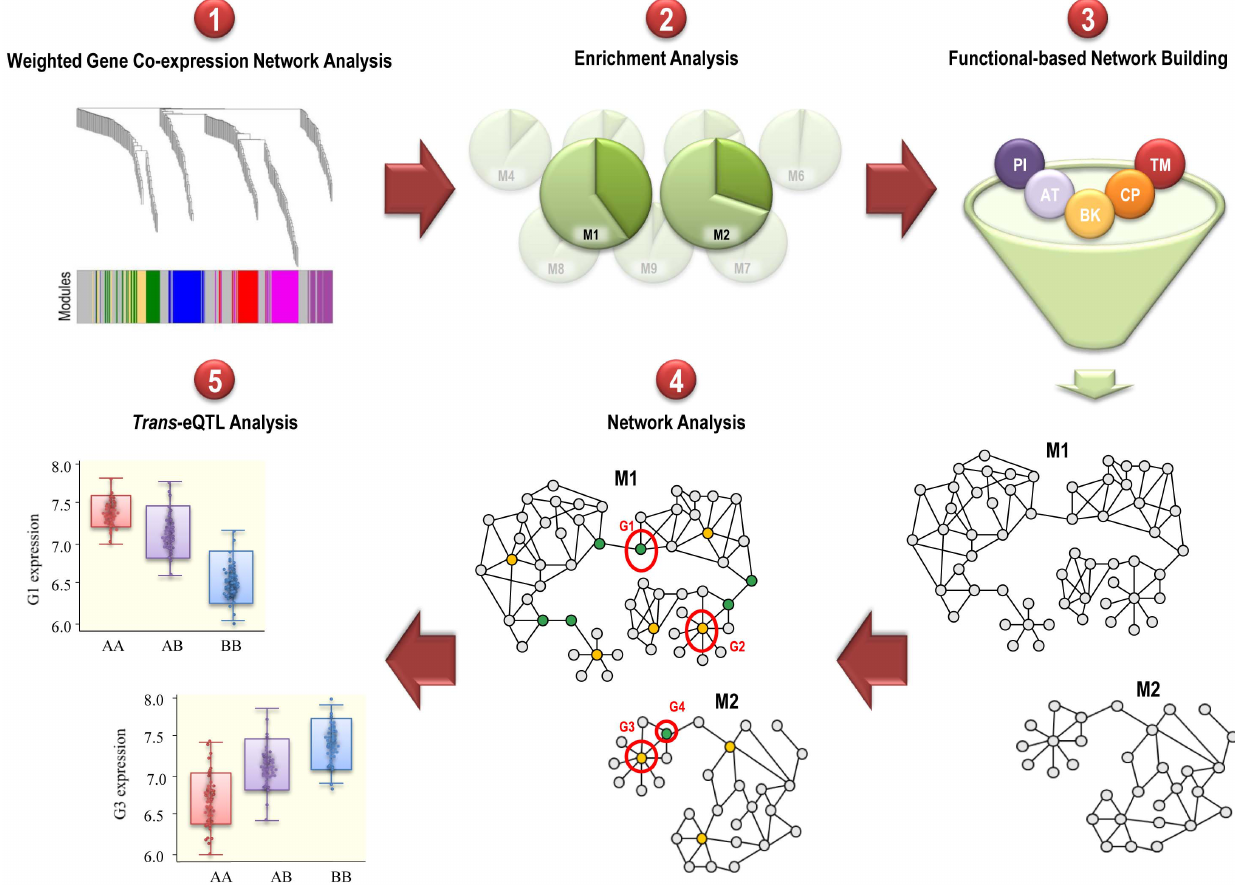
Figure 1. Workflow of the systems genetics approach for trans -eQTL identification. The new systems genetics approach is based on four steps that are performed before the trans -eQTL analysis in order to efficiently reduce the number of analyzed genes: 1) Identification of the gene expression modules (M) that characterize CD4 + T cell gene expression 2) Enrichment analysis of a specific biological process that is related to the trait of interest 3) Construction of the functional-based networks using biological knowledge within the significantly enriched modules 4) Network analysis to identify those genes that are likely to play a central role in the functional-based networks 5) Trans -eQTL analysis using the subset of genes that show the highest centrality in each module. Abbreviations: AT, association transfer between organisms; BK, curated biological pathway knowledge; CP, computational predictions; G, gene; M, module; PI, physical interactions; TM, text-mining.